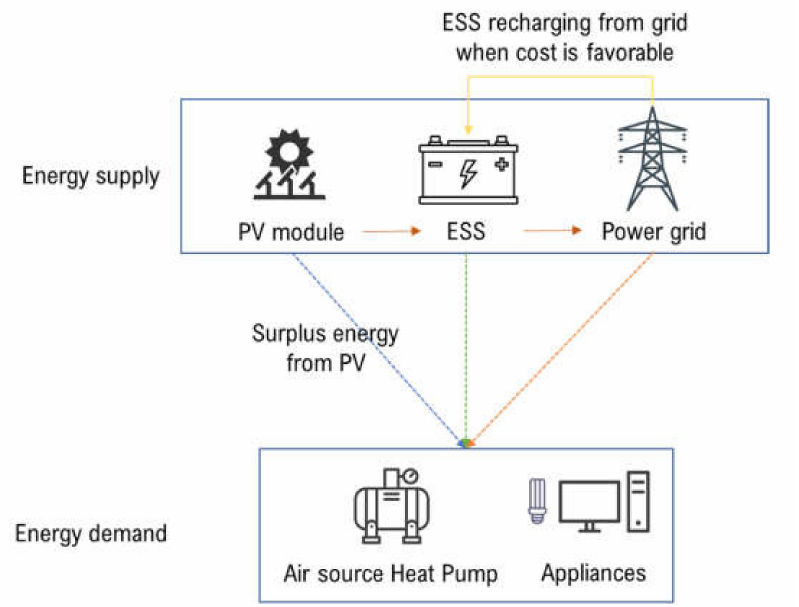
Figure 1. Target building and energy system